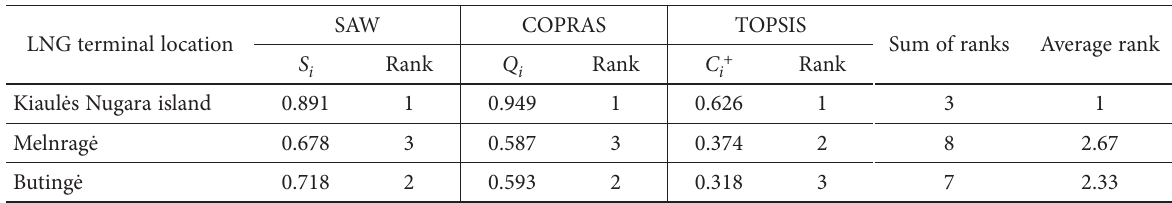
Table 2. Ranking of